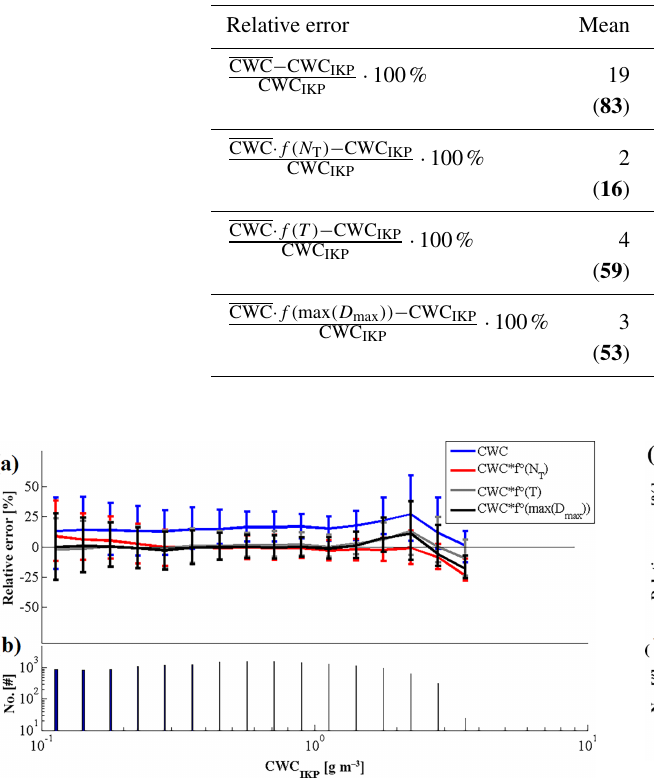
Figure 6. Same as Fig. 3 but represented as a function of CWC IKP on the x axis.